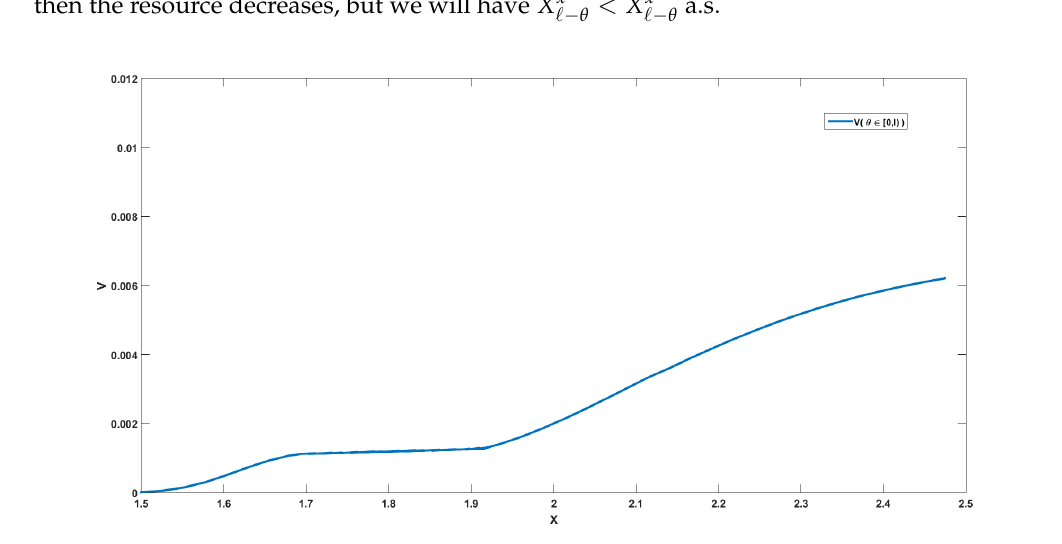
Figure 1. The shape of the value function v sliced in the plane of x